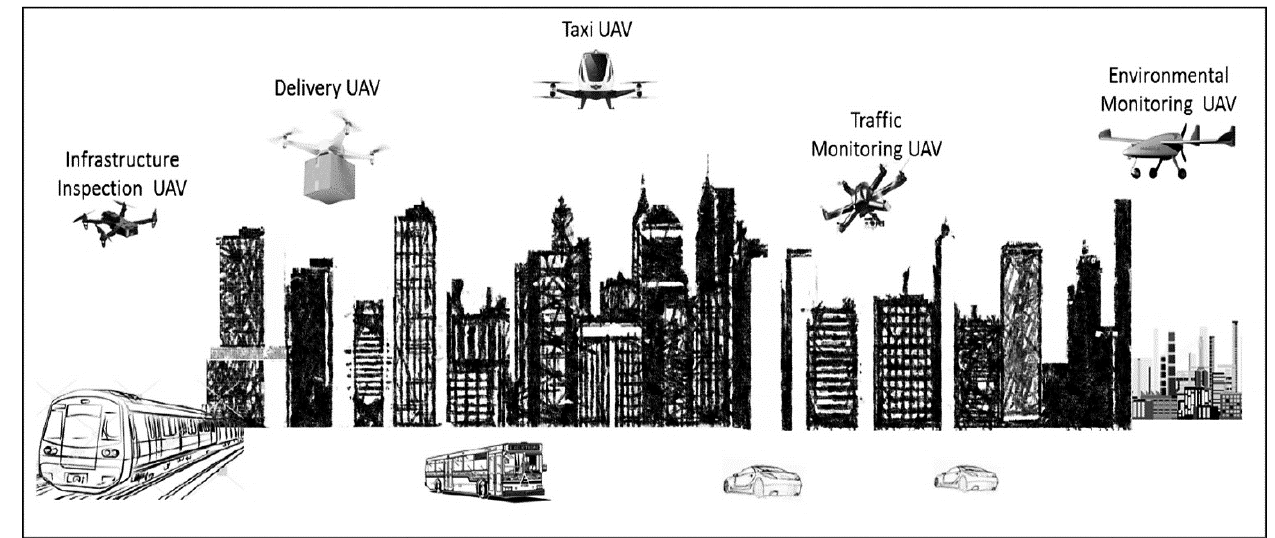
Figure 1. Using UAVs for various purposes in the smart environment [1].